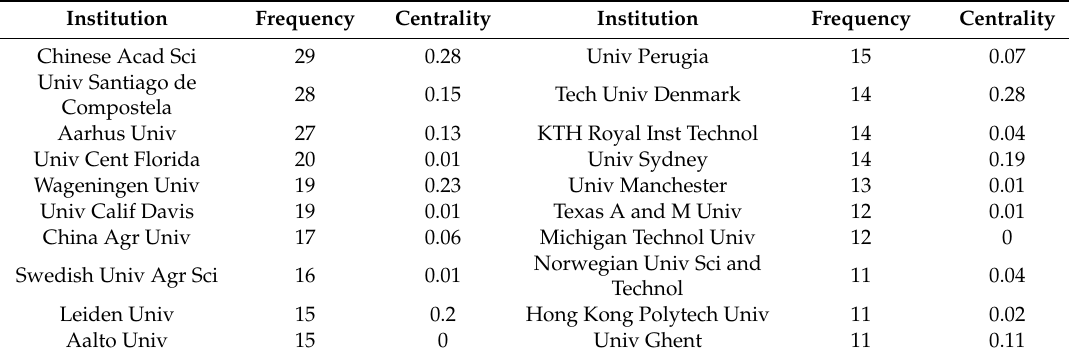
Table 8. Top 20 institution based on occurred frequency.